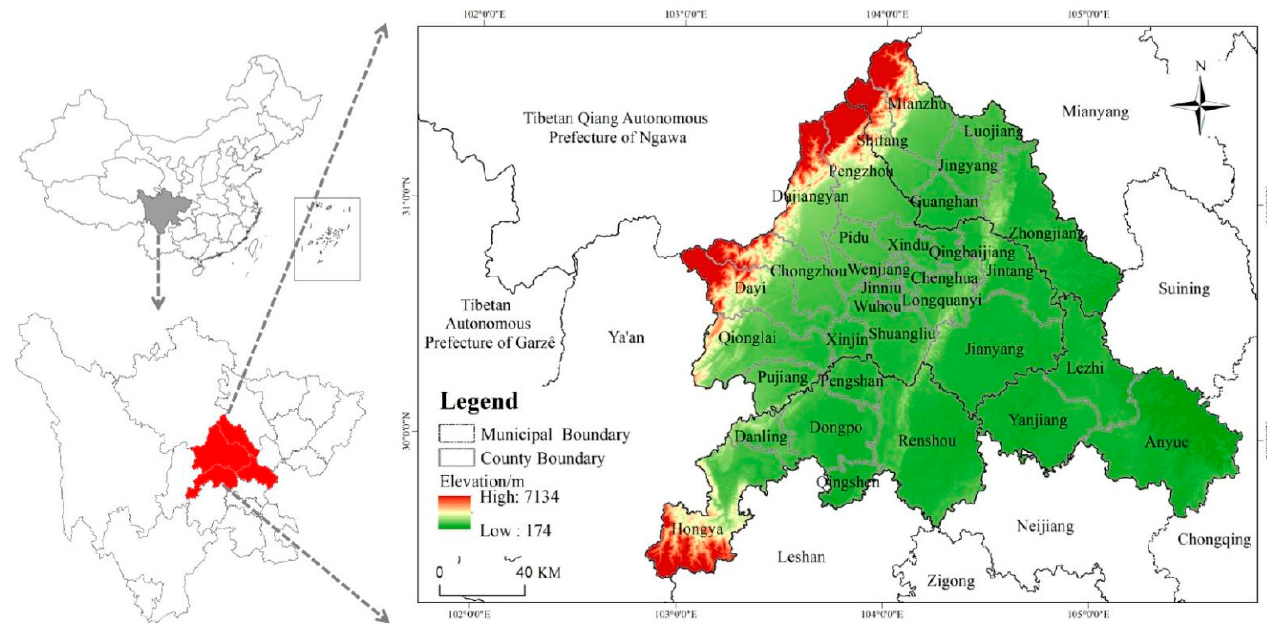
Figure 1. Geographical location of the study area.